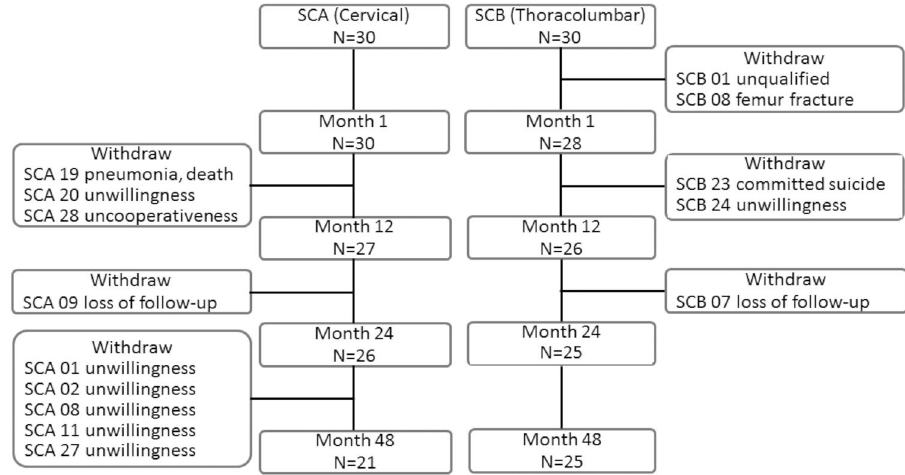
Figure 1. Algorithm of enrollment and withdrawal. N = number of patients; SCA = cervical SCI group; SCB = thoracolumbar SCI